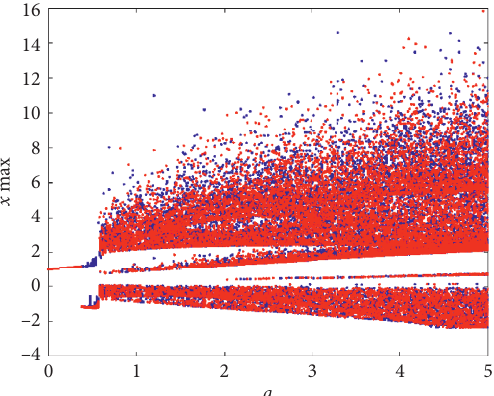
Figure 21: Bifurcation diagram versus the parameter a at ( 0 . 2 , 0 . 2 , 0 . 2 ) and ( 0 . 2 , 0 . 2 , 0 . 5 ) .